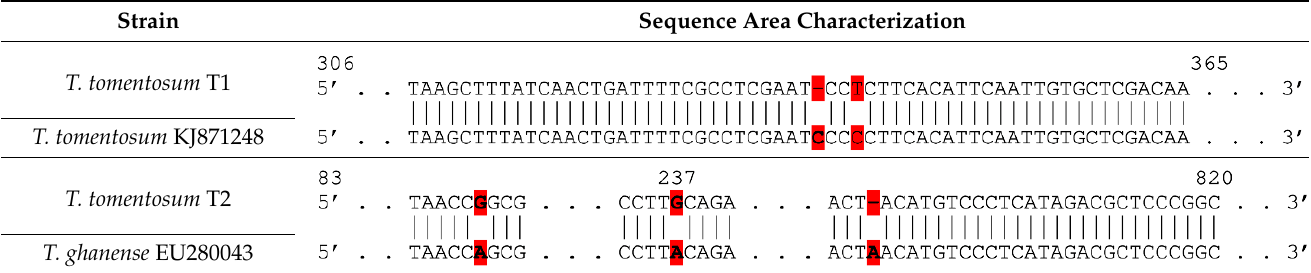
Table 3. Characterization of Trichoderma strains according to TEF1 gene region differences.